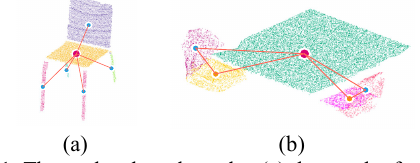
Figure 1. The anchor-based graphs: (a) the graph of one chair, where red node represents the anchor   and yellow line between red node and blue node represents edge; (b) the graph of a sub-scene with one table and two chairs, where yellow node represents the sub-anchor   .